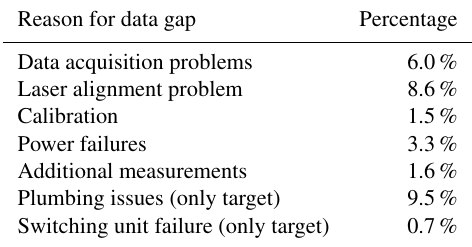
Table 8. Percentage of total measurement time for major data gaps. The latter two data gaps concerned only target gas